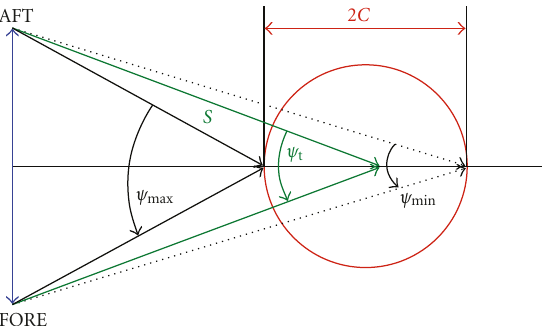
Figure 6: Phasor diagrams showing the relationship between the ideal phase ψ t , the maximum phase ψ max (solid lines), and the minimum phase ψ min (dotted lines) for given S and C .